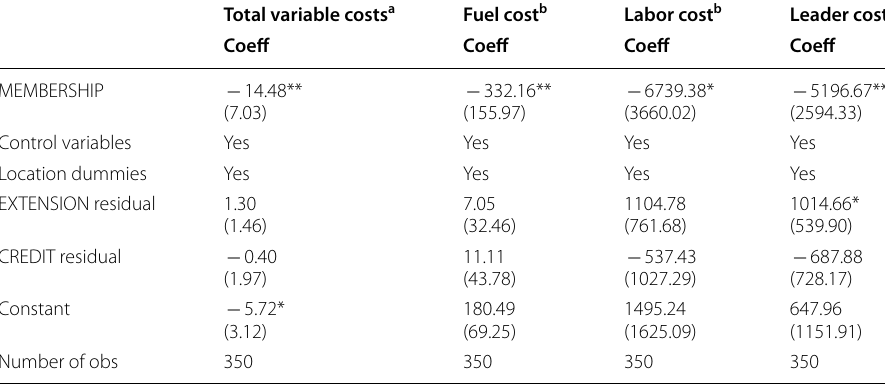
Table 9 Effect of group membership on input